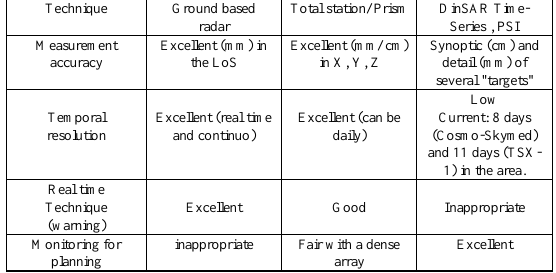
Table 1. Attributes of displacement measurement techniques for the open pit iron mines of